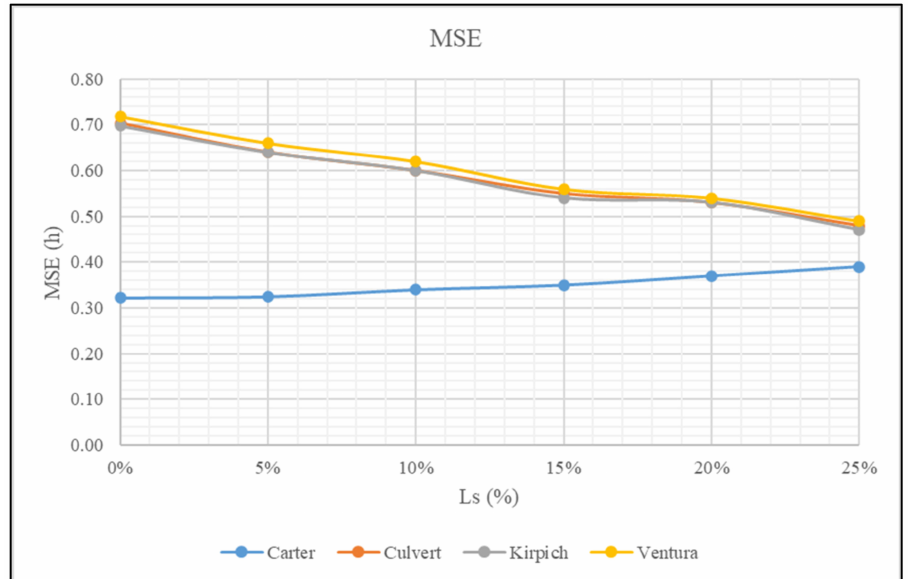
Figure 7. Calculation of MSE changing Ls.